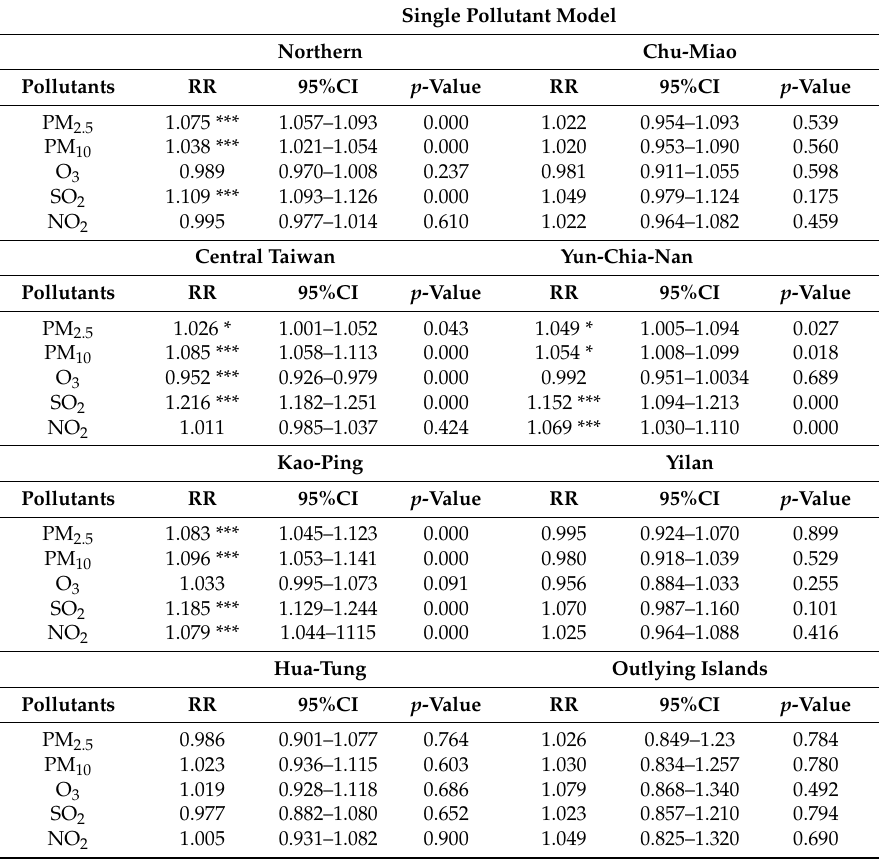
Table 5. Relative risks of asthma hospitalization associated with air pollutants in different regions—a single pollutant